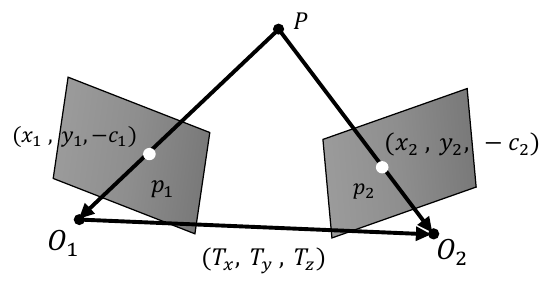
Figure 1. The co-planarity model relating